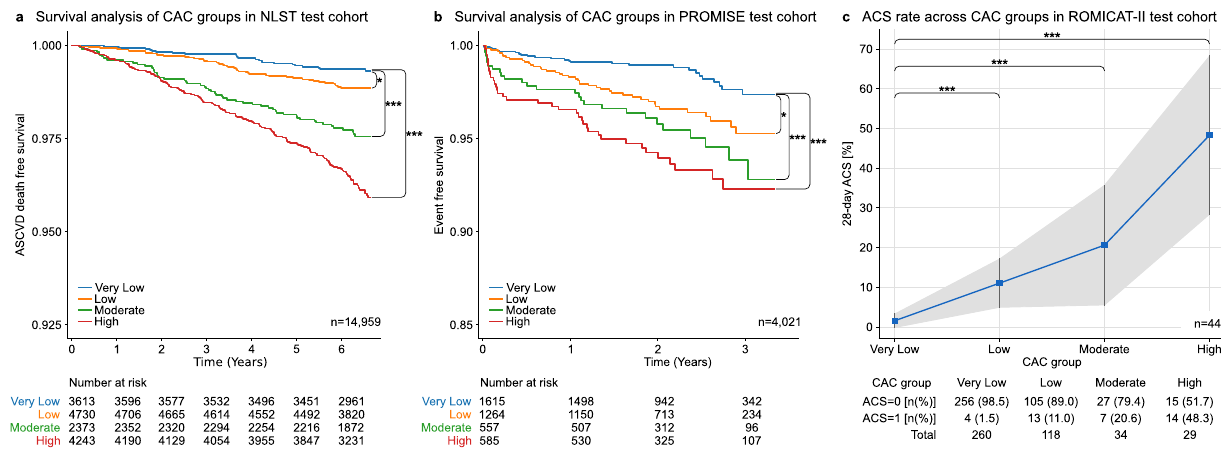
Fig. 2 Outcome analysis for deep learning predicted calcium scores. Kaplan – Meier survival analysis of CAC risk groups for a cardiovascular disease- related death for 14,959 subjects of the National Lung Screening Trial (NLST) 18 and b all-cause mortality, myocardial infarction and unstable angina for 4021 subjects of the Prospective Multicenter Imaging Study for Evaluation of Chest Pain (PROMISE) 19 . A two-sided log rank test was used to calculate the p values (* p value ≤ 0.05; *** p value ≤ 0.001) in panels ( a ) and ( b ). c Thirty-day acute coronary syndrome (ACS) rate across CAC groups for 441 subjects from the Rule Out Myocardial Infarction using Computer Assisted Tomography II (ROMICAT-II) 20 trial. The shaded area corresponds to the 95% con fi dence interval of the 30-day ACS rate across CAC groups. A two-sided Fisher ’ s exact test was used to estimate differences in the ACS rate between the very low risk group and the low, moderate, and high risk groups (*** p value ≤ 0.001). CAC coronary artery calcium, ASCVD atherosclerotic cardiovascular disease, ACS acute coronary syndrome. CAC risk groups: Very low: 0; Low: 1 – 100; Moderate: 101 – 300; High: >300 21